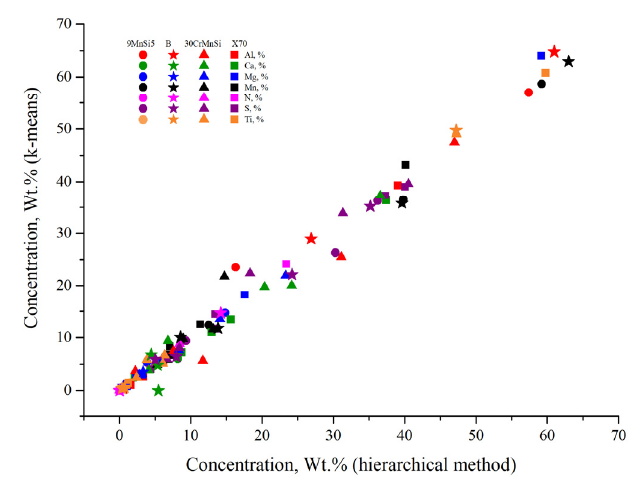
Figure 2. Comparison of hierarchical clustering and k ‐ means.